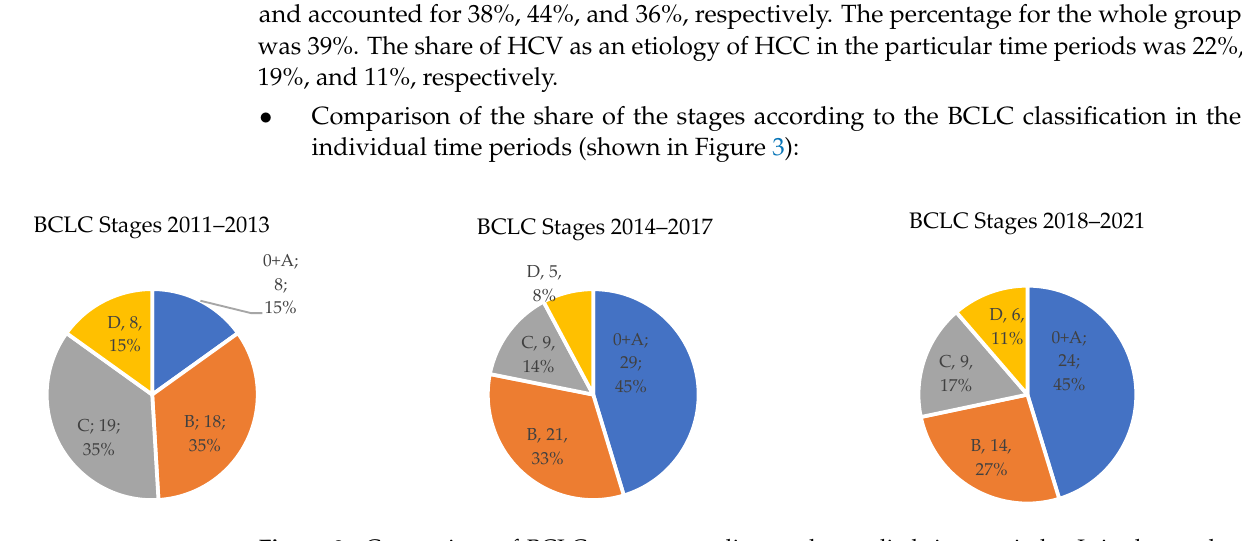
Figure 3. Comparison of BCLC stages according to the studied time periods. It is shown that initial changes in approach to patients with risk of developing HCC (systematic application of HCC surveillance) and classification according to the BCLC classification led to the change in the distribution of the initial stage at the time of diagnosis to earlier stages. This effect was sustained to the end of the studied period.